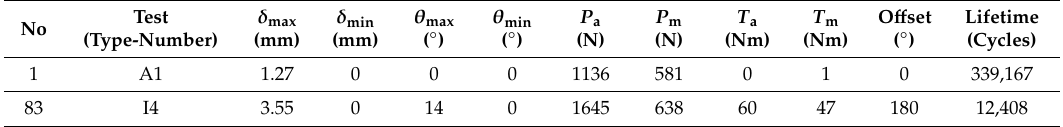
Figure 1. 3D model for the calculation of stresses, strains and energies, based on Mars and Fatemi tests [45]. Table 1. Information of Mars and Fatemi battery tests. Initial test data adapted from [45].